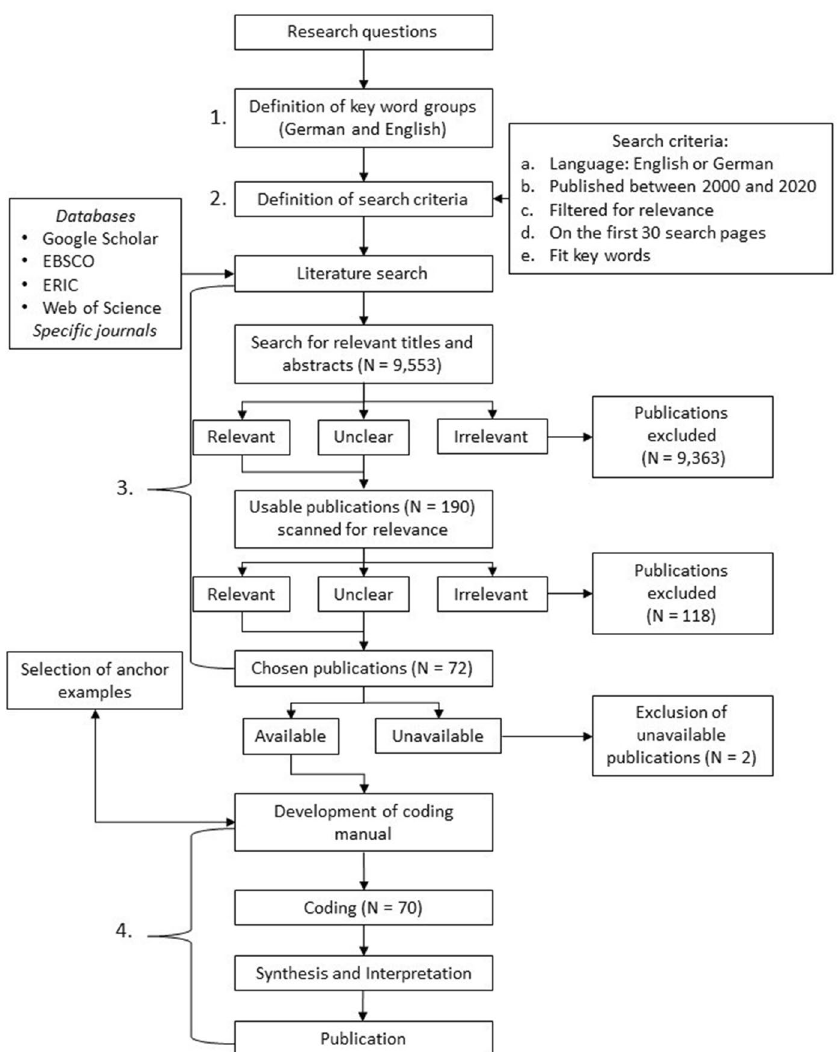
Fig. 2 Flow chart of research